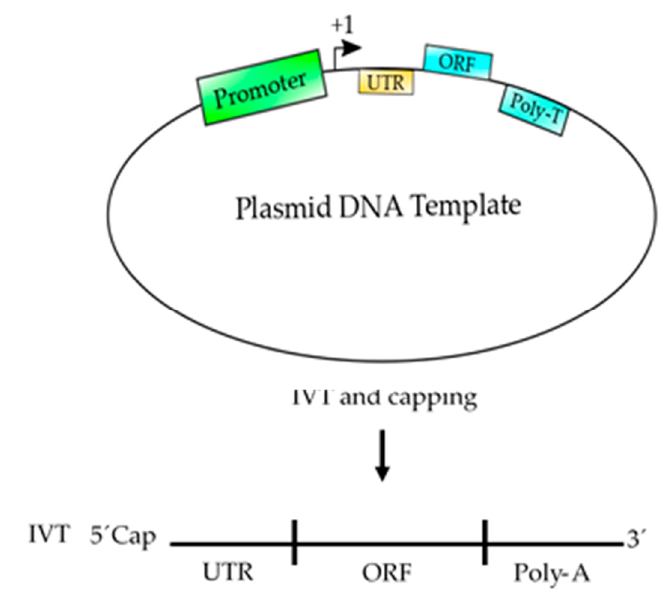
Figure 6. Schematic representation of a plasmid DNA template used to produce an mRNA-based vaccine. This template contains the basic elements to produce a functional mRNA. A promoter is needed for the RNA polymerase to start transcription at the + 1 site. The 5 (cid:48) UTR is added to enhance the translation and the stability of the mRNA and the ORF contains the coding sequence of the antigen, which could be synthetized according to the codon usage to enhance the translation process. Finally, a poly T of at least 200 nucleotides is needed to produce a poly A tail on the mRNA. After, the template is transcribed (in vitro transcription, IVT) using RNA polymerase and ribonucleotides to produce an mRNA, which should be 5 (cid:48) capped to produce a functional mRNA to be used as